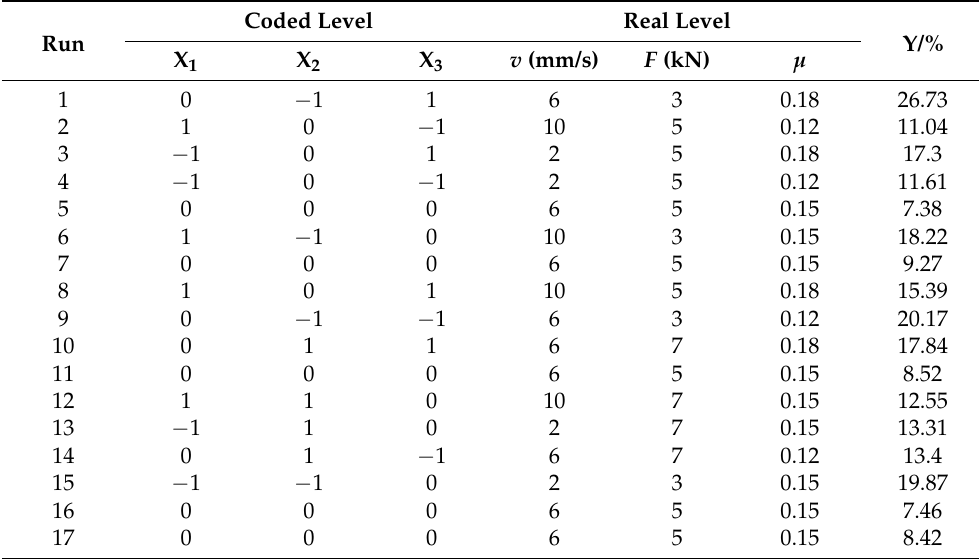
Table 4. Experimental arrangement and response from hot-stamping